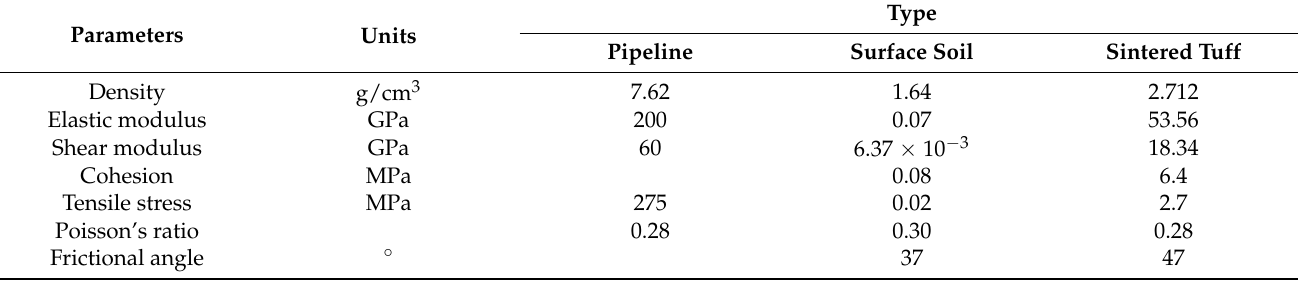
Table 6. Material